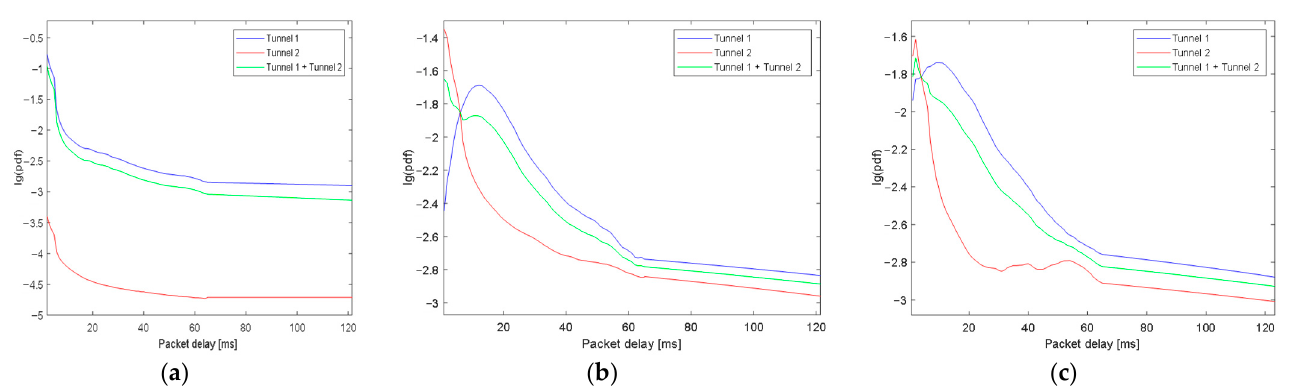
Figure 14. Statistical characterization of the packet delays on the aggregated virtual tunnels when 2 APs and different user clustering algorithms are used: ( a ) The pdfs of the packet delays when no user clustering algorithm is used; ( b ) The pdfs of the packet delays when the non-cooperative user clustering algorithm is used; ( c ) The pdfs of the packet delays when the cooperative user clustering algorithm is used.